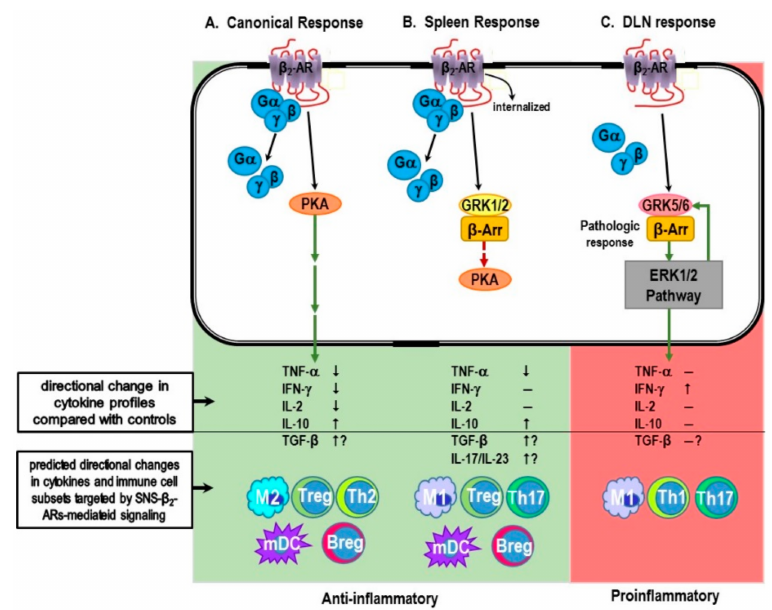
Figure 4. ( A ) Canonical β 2 -adrenergic receptor ( β 2 -AR) signaling response, the anti-inflammatory cytokine profile mediated by protein kinase A (PKA), and the major anti-inflammatory cellular mediators of the resulting anti-inflammatory immune response. ( B ) The physiological G protein-coupled receptor kinase (GRK)1/2-mediated β 2 -AR desensitization/downregulation in spleen cells from rats with inflammatory arthritis, the reported directional changes in cytokine profiles ( C ) The pathological GRK5/6-mediated activation of the ERK1/2 pathway in immune cells from